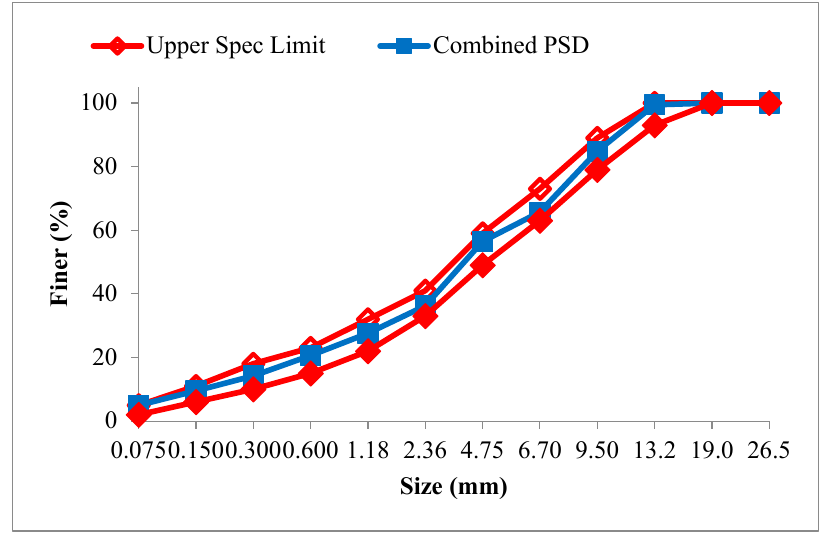
Figure 3. PSD of Mix 2.